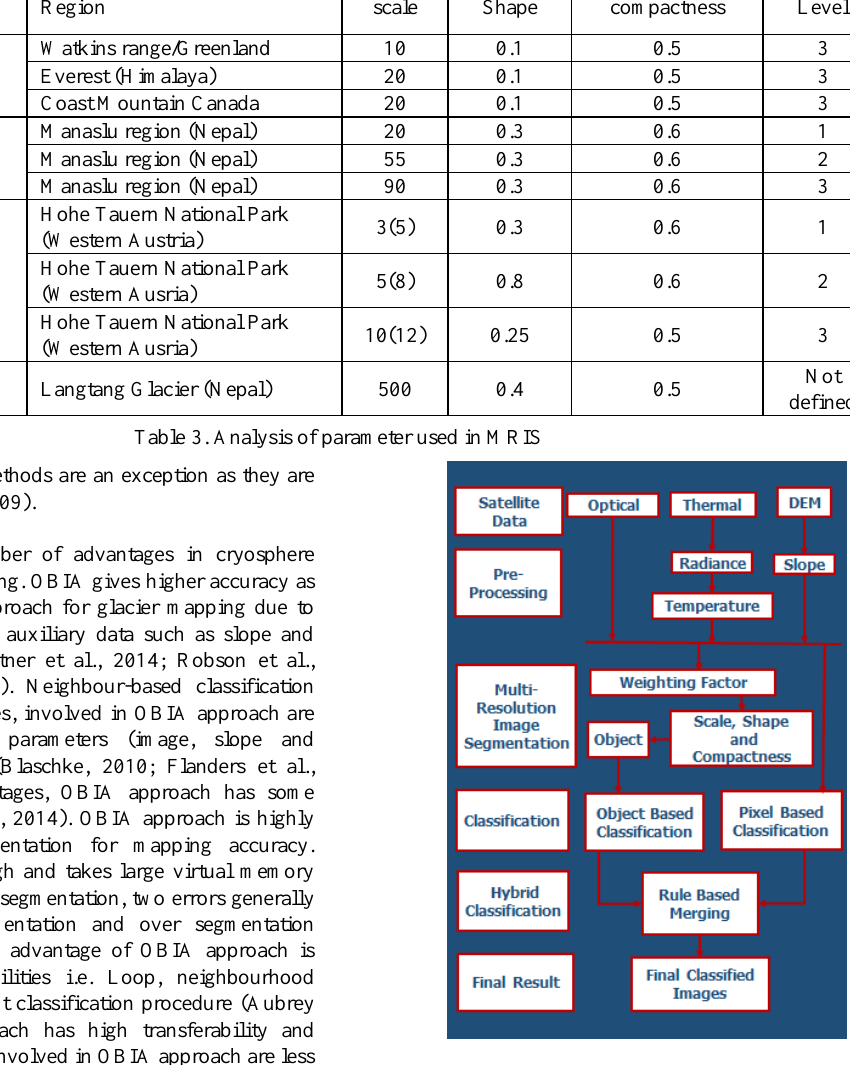
Figure 2. Flow chart of combined pixel and Object